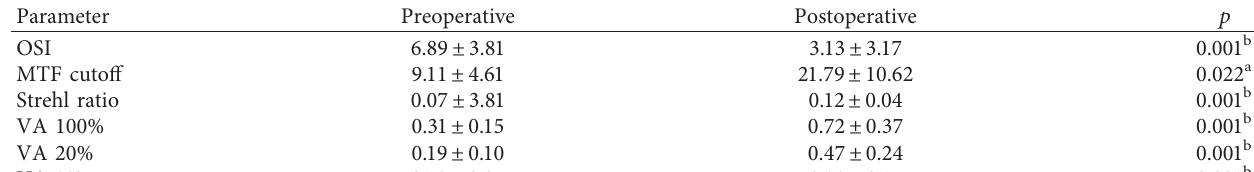
Figure 7: Preoperative and 3 months postoperative coordinate point of astigmatic vectors ( J astigmatism. Table 4: Optical quality values preoperatively and 3 months postoperatively. Parameter